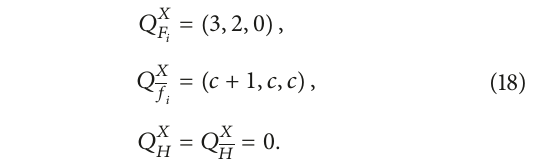
Table 1: The quark textures in the SSMs and 𝑆𝑈(5) models. Yukawa The SSMs 𝑆𝑈(5)